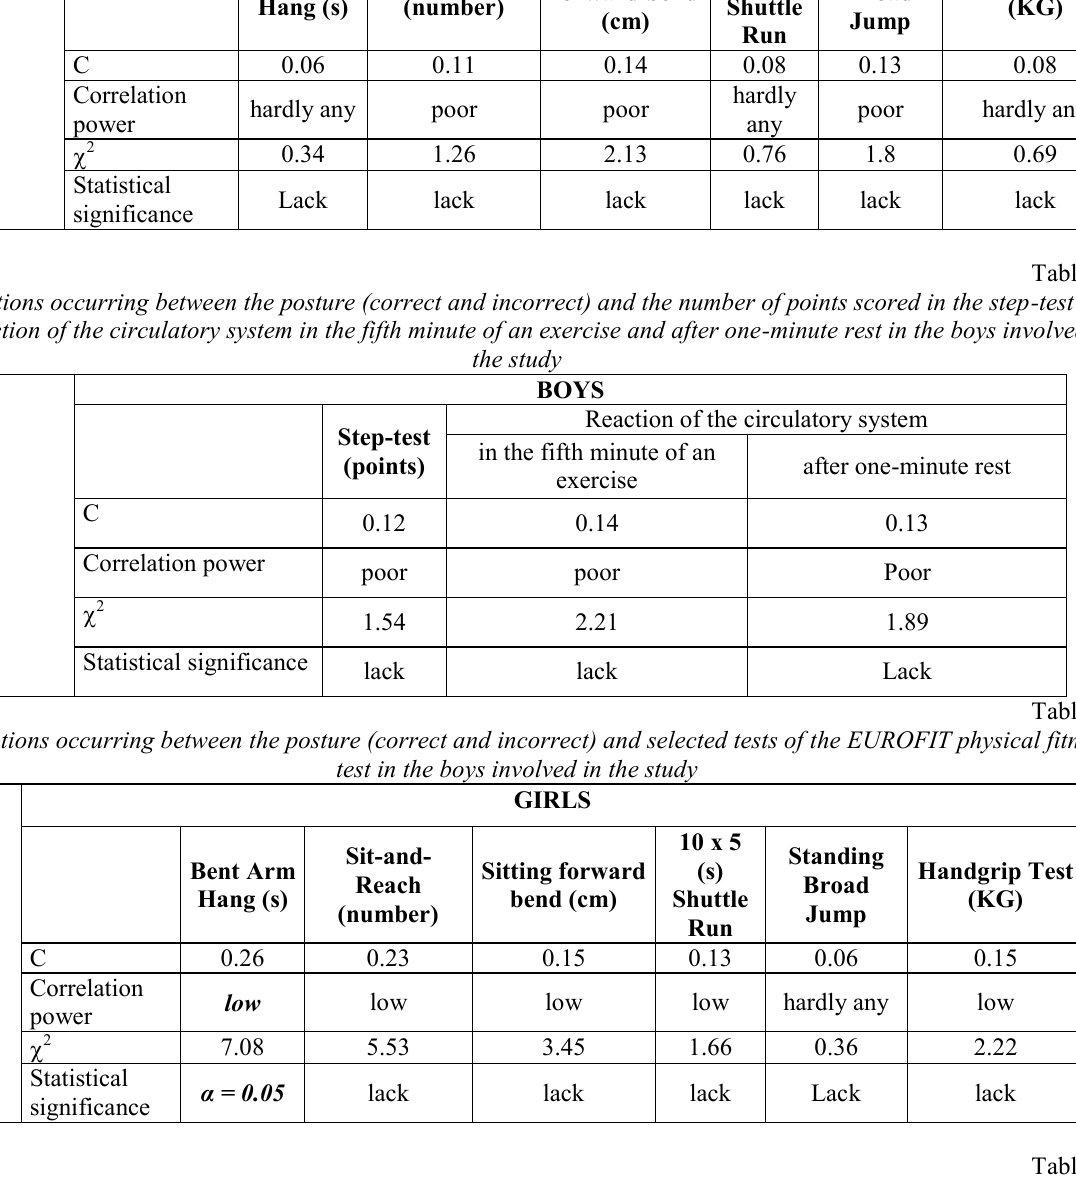
Correlations occurring between the posture (correct and incorrect) and the number of points scored in the step-test and the reaction of the circulatory system in the fifth minute of an exercise and after one-minute rest in the boys involved